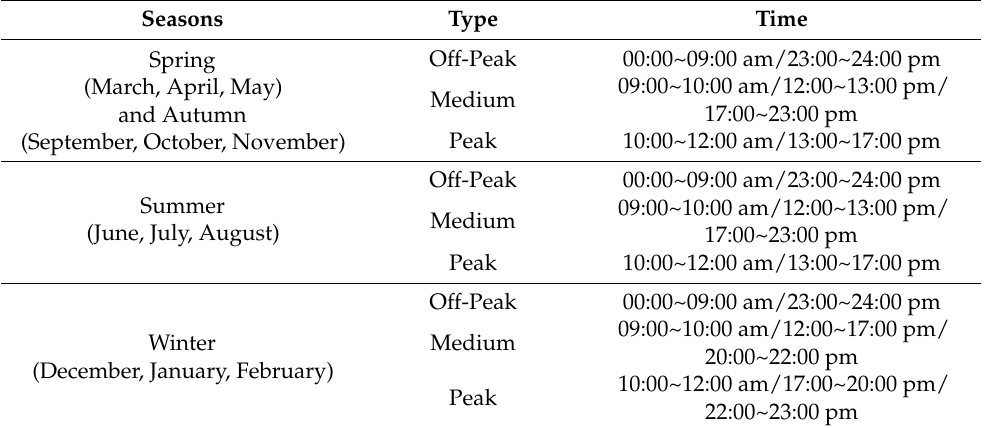
Table 4. The time range for the current seasonal Time-of-Use (ToU) tariff in South Korea. Seasons Type